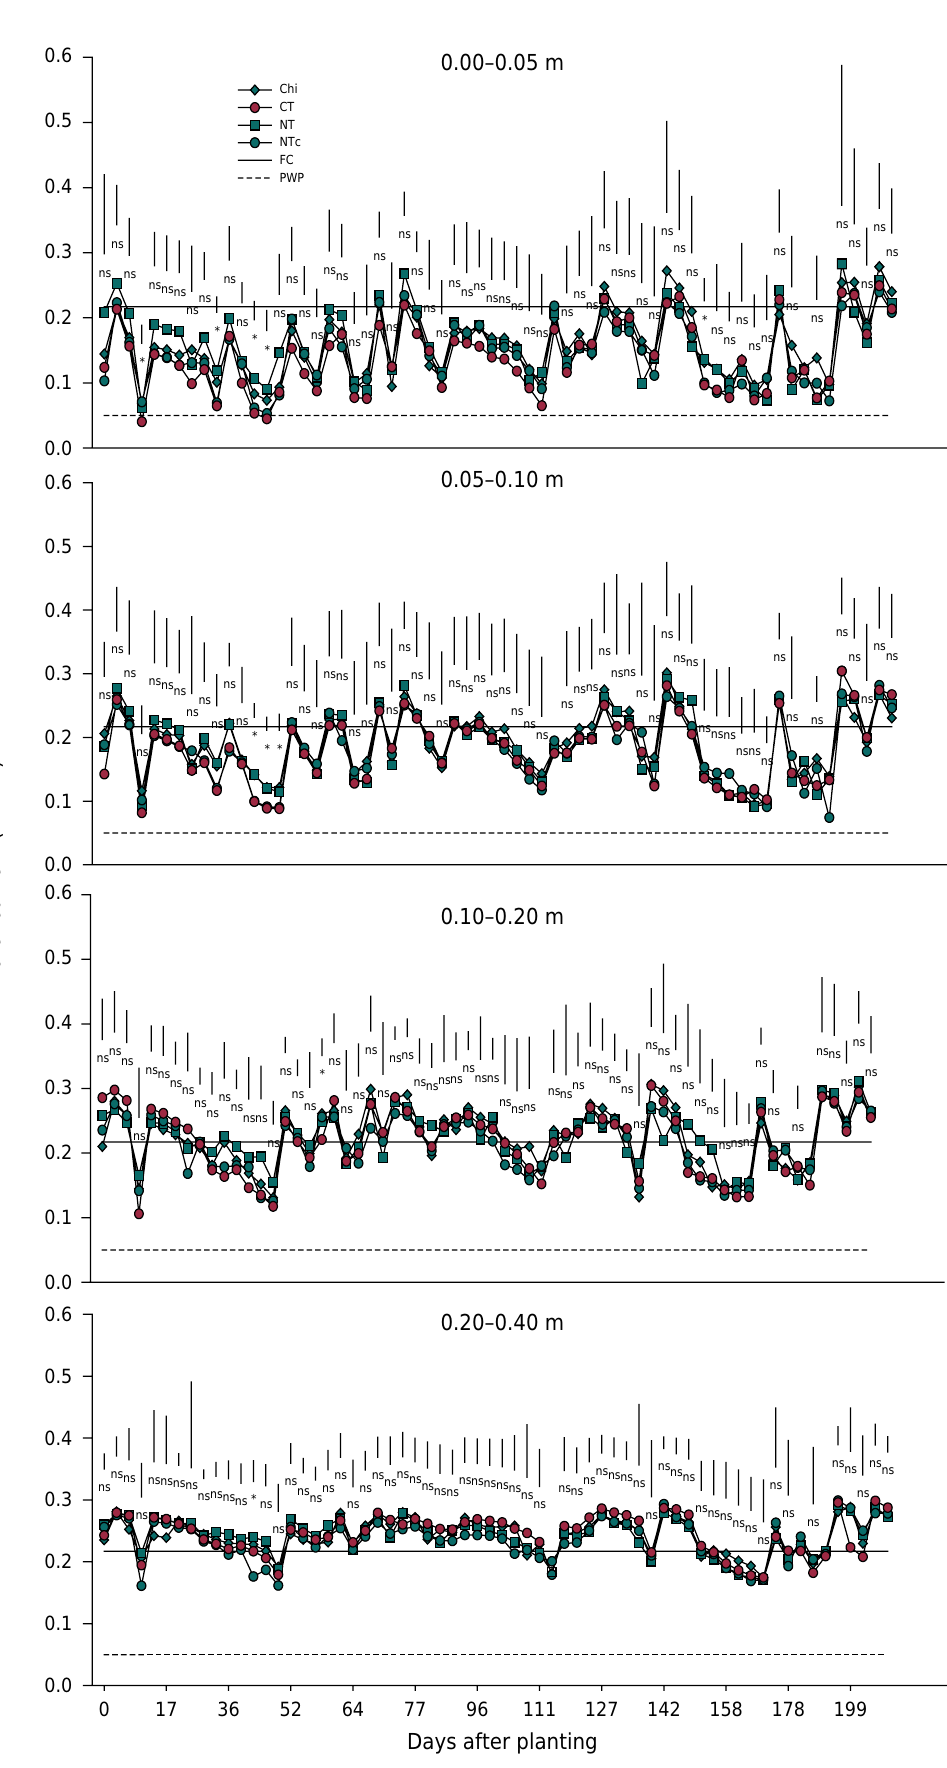
Figure 5. Soil water content during the cassava cycle for chisel plough (Chi), conventional tillage (CT), no-tillage (NT), and compacted no-tillage (NT C ), in four soil layers, during cassava growth. *: significant (DMS test, 5 % probability level); ns: not